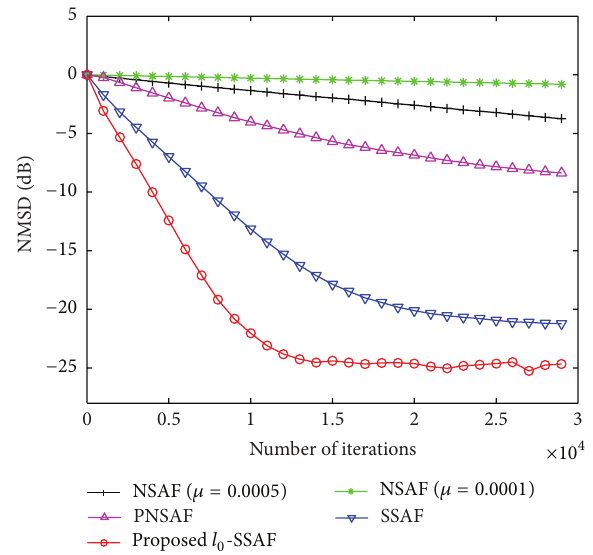
Figure 4: NMSD learning curves of the NSAF, PNSAF, SSAF, and 𝑁 = 4 , SIR = −10 dB, input: Gaussian AR (1) 𝑙 0 -SSAF algorithms [ with pole at